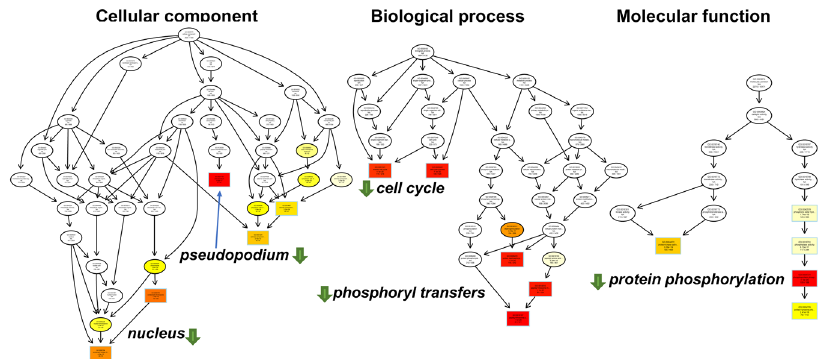
Fig. 6 GO enrichment of the differential transcriptomes between the S + and S- samples at Day 4. The GO Directed acyclic graph (DAG) shows the enriched GO terms in the downregulated cellular component, biological process, and molecular function categories. The boxes and circles represent GO terms and are labeled with the GO ID on the fi rst line, the term de fi nition and information on the second line and the p -value on the third line. The fourth line is labeled with the number of regulated genes associated with the listed GO ID and the total number of genes. Annotation moves from more general to more speci fi c with progression from the parent nodes. The top-ranked terms with the lowest p -values are marked with boxes and yellow/red colors. The more red-saturated a node is, the greater its signi fi cance.